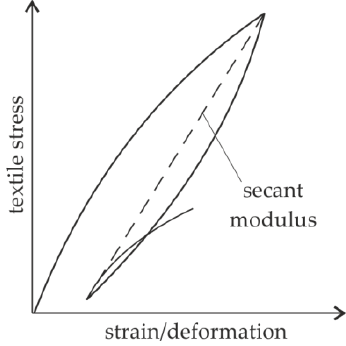
Figure 10. Determination of the secant modulus.